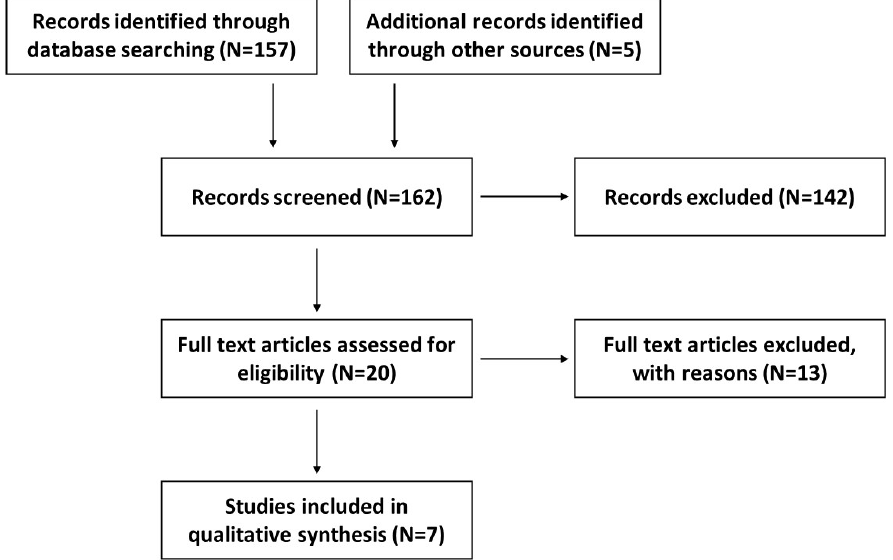
Figure 2. A flow diagram outlining the record identification and selection